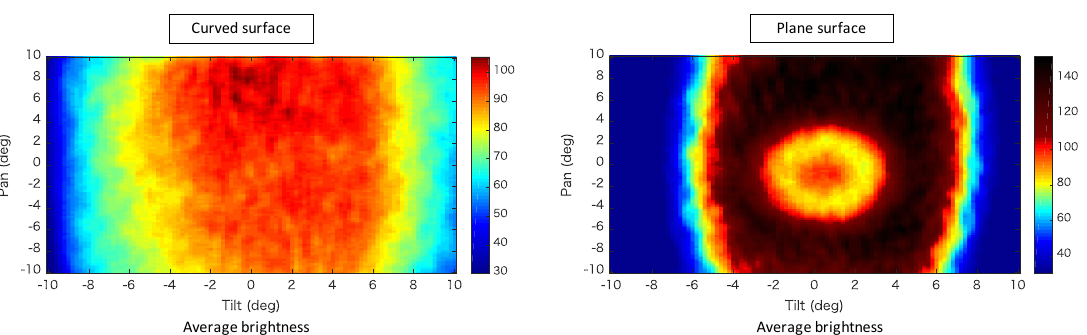
Figure 7. Composite images.